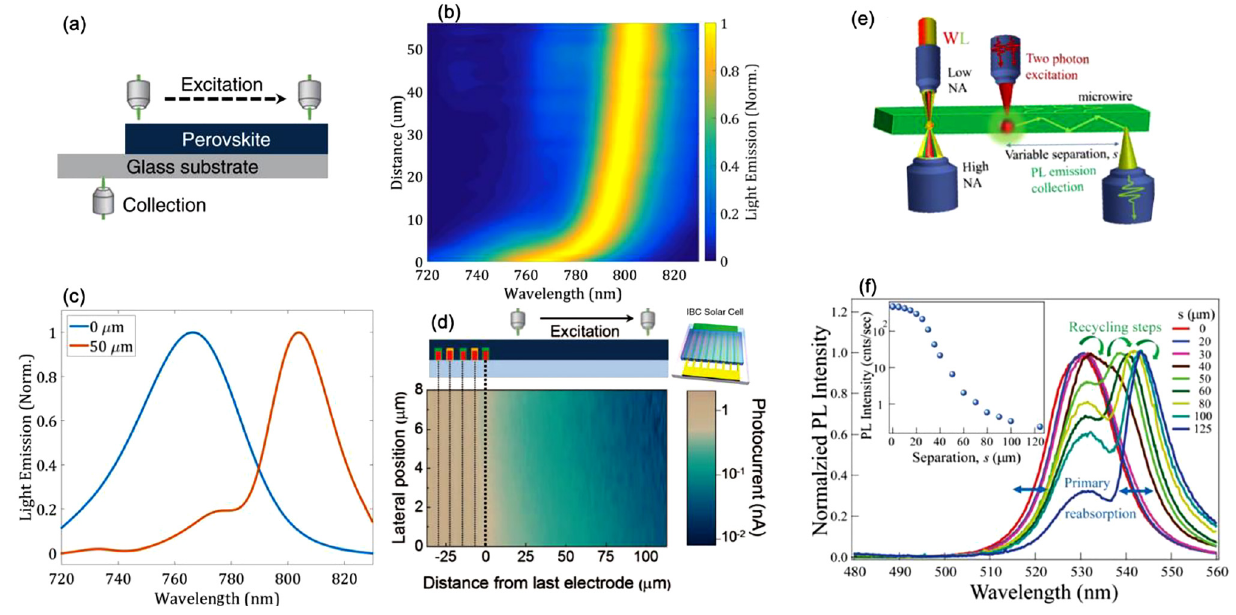
Figure 6: Spatial-distribution mapping of emission and photoluminescence (PL) of a perovskite film deposited on a glass substrate.